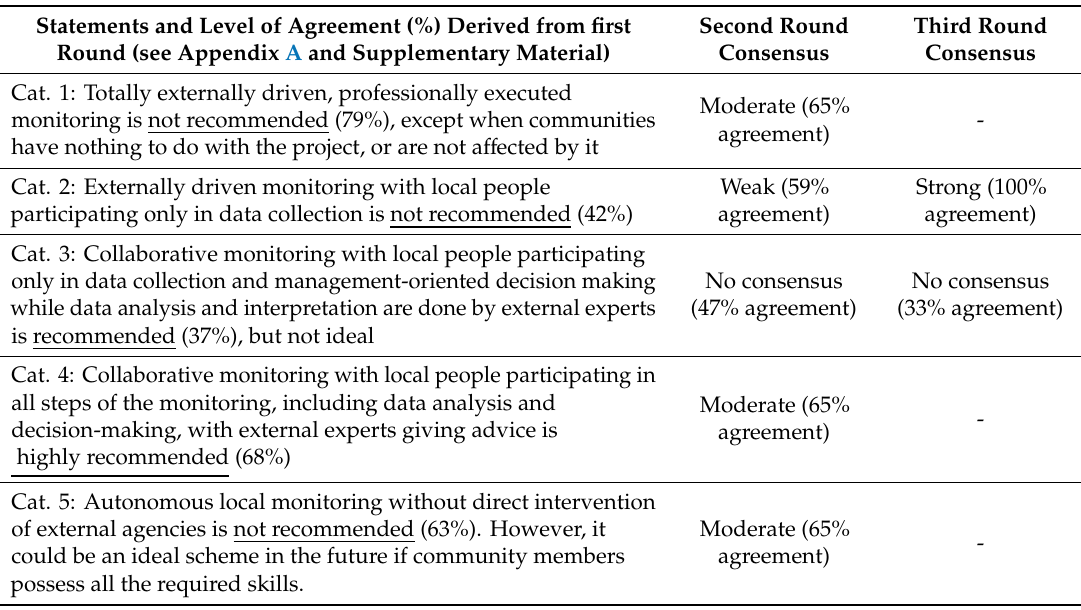
Table 4. Delphi panel results on the recommend monitoring scheme for community-based monitoring of REDD + projects in the DRC. Categories (Cat.) according to Danielsen et al. [15] in the order of increasing community participation in the monitoring